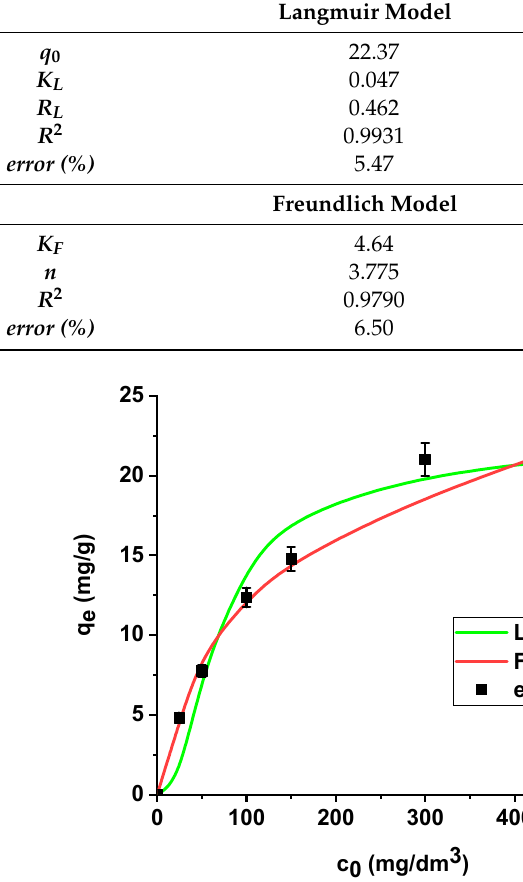
Figure 14. The Langmuir and Freundlich sorption isotherms of As(V) on X np (pH 6, shaking speed 180 rpm, temperature 295 K).